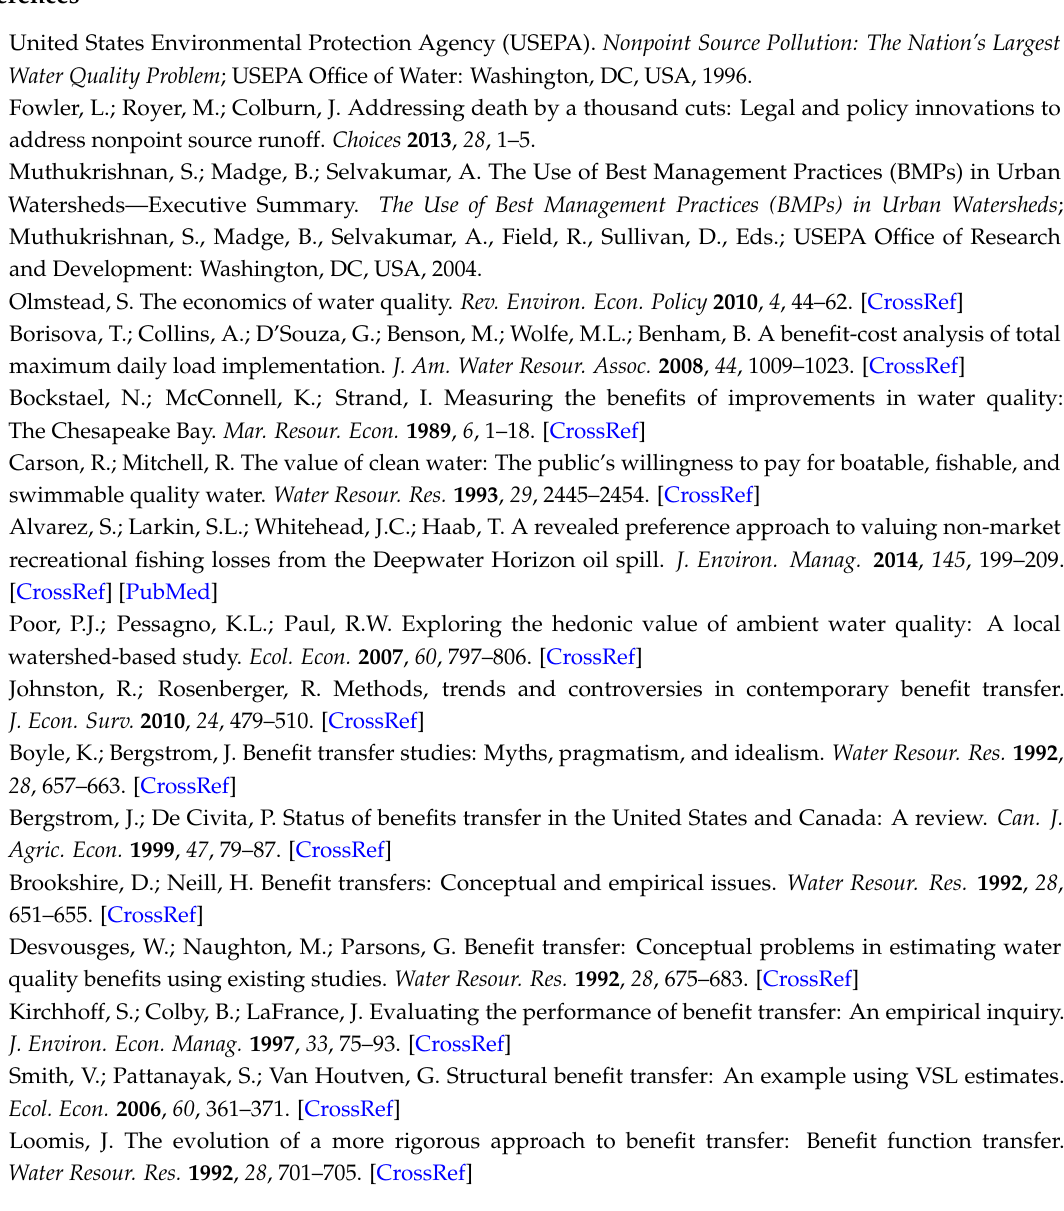
Table S1: Correlation Matrix of the dependent and the independent variables. Table S2: Forecasted individual and total willingness to pay for an improvement in water quality from level 5 (fishable) to level 7 (swimmable), by county. Table S3: Sensitivity Analysis for Different Proportion of Water Body Users and for payment vehicle other than an increase in taxes in the Population of